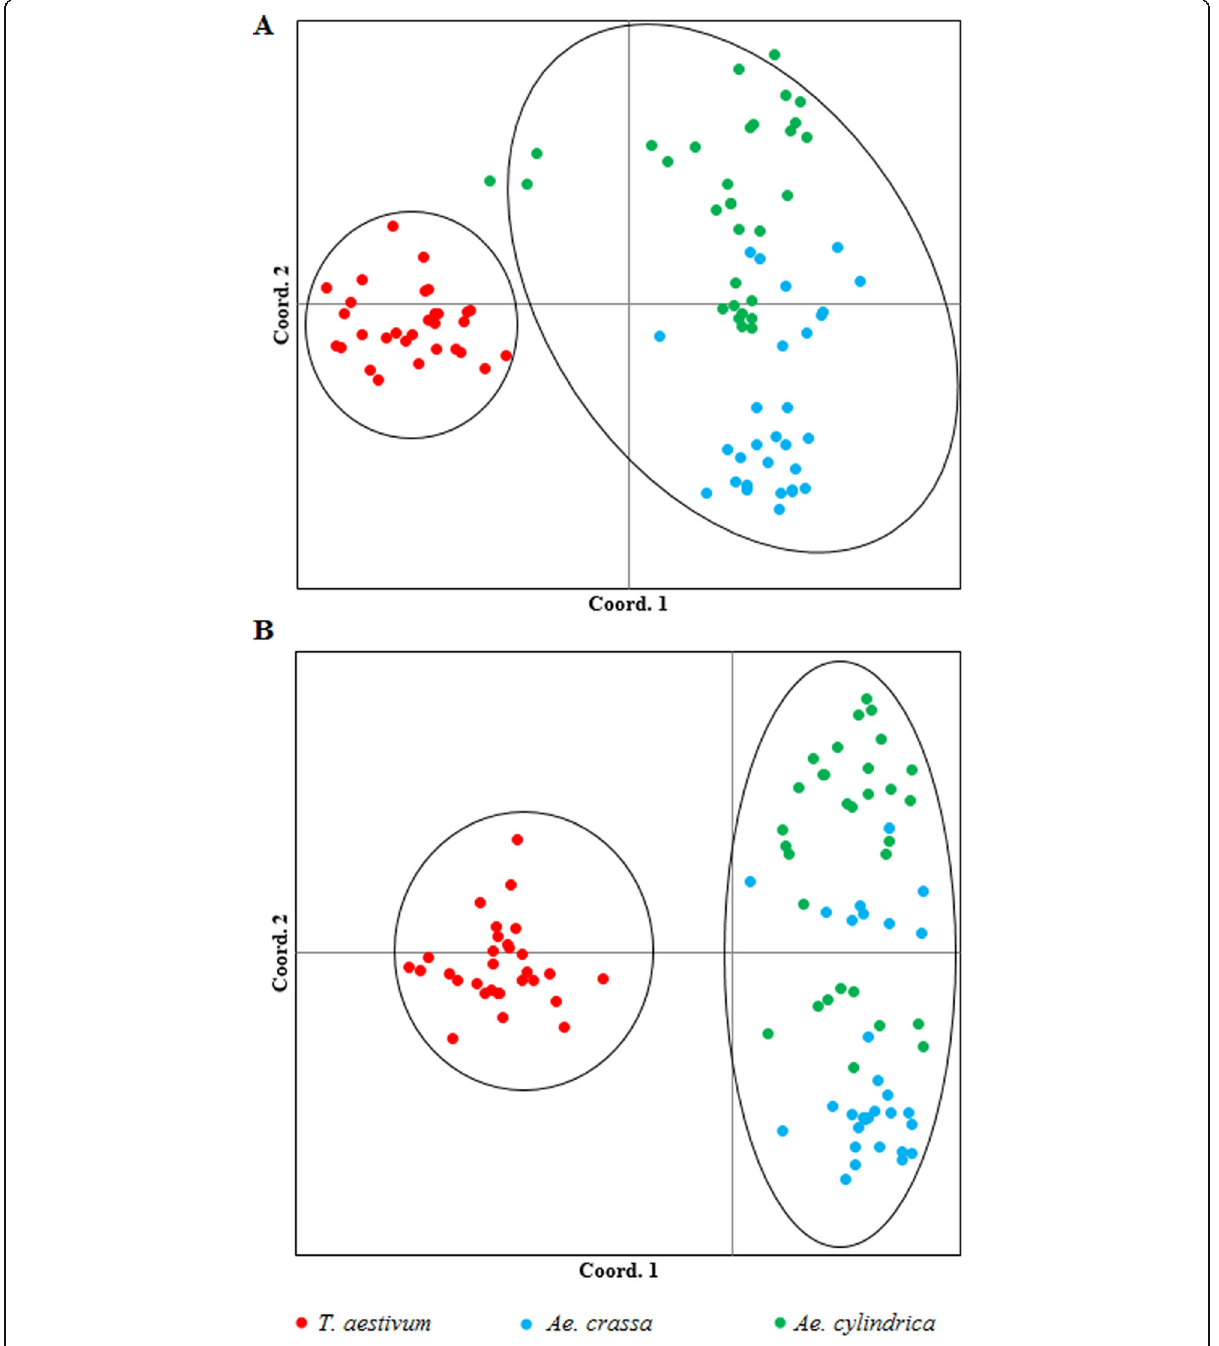
Fig. 4 Principal coordinate analysis (PCoA) using SCoT (panel a ) and CBDP (panel b